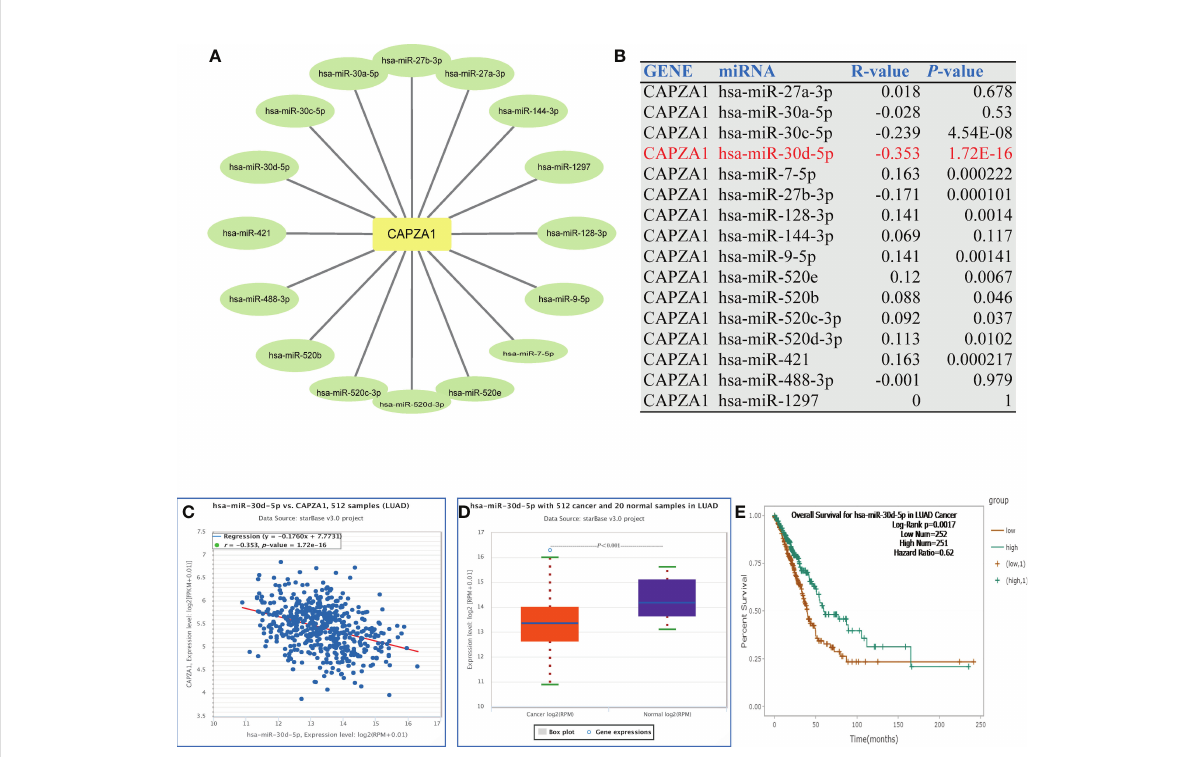
FIGURE 4 Identi fi cation of miR-30d-5p as a potential upstream miRNA of CAPZA1 in LUAD. (A) The miRNA- CAPZA1 regulatory network established by Cytoscape software. (B) The expression correlation between predicted miRNAs and CAPZA1 in LUAD as analyzed by the starBase database. (C) The expression correlation between miR-30d-5p and CAPZA1 in LUAD as analyzed by the starBase database. (D) The expression of miR-30d-5p in LUAD and control normal samples determined by the starBase database. (E) The prognostic value of let-7c-5p in LUAD assessed by the starBase